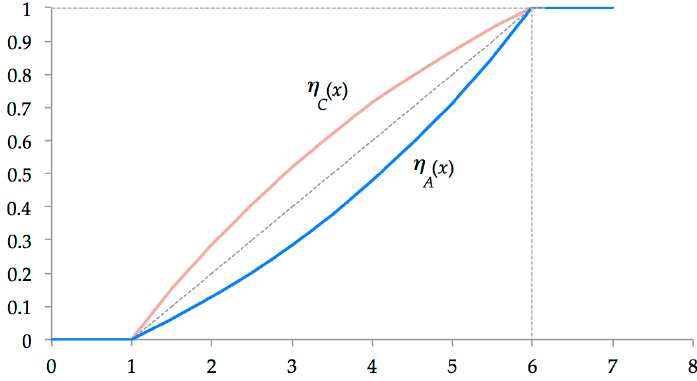
Figure 3. Similarity functions of academic, η A ( x ) , and cognitive η C ( x ) dimensions.